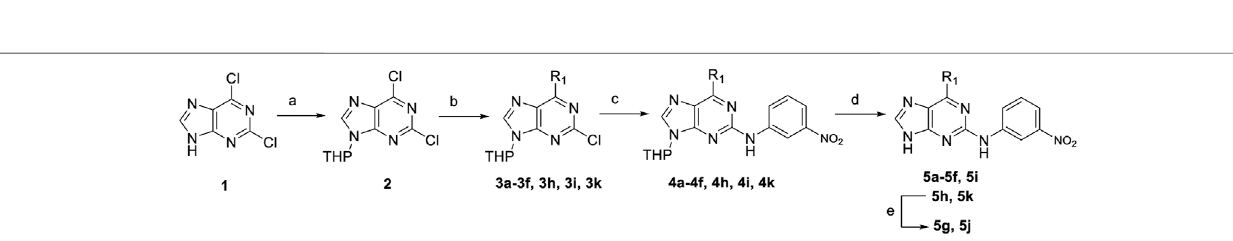
FIGURE2|(A) Calculatedbindingpocketsofcompound 73 inCDK2.Pocketsarerepresentedusingsphereslocatedatthecentroidofeachalpha-cluster. (B) The table presents pocket features including space, occupancy, and nonpolar rate.